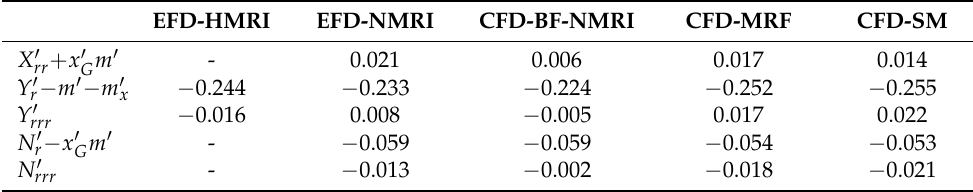
Table 10. Hydrodynamic derivatives obtained from CMTs ( β = 0 ◦